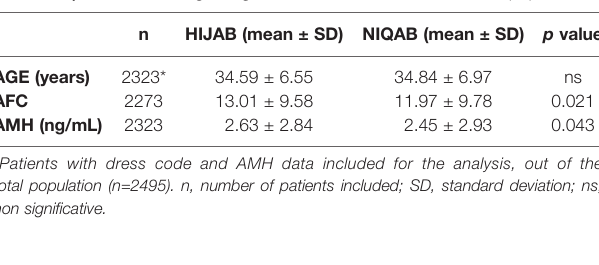
TABLE 5 | Distributions regarding conservative dress code for Arab population.